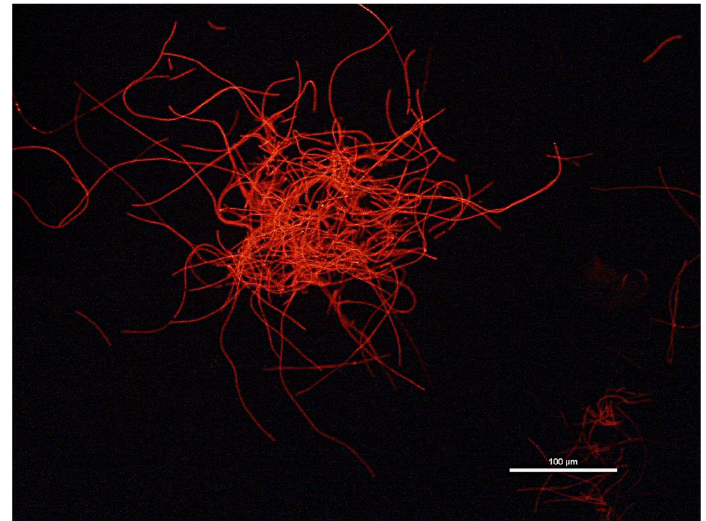
Figure 2. UV microphotograph of the cyanobiont culture obtained during passage (Nikon Eclipse 80i microscope, magnification 4x, UV2A filter, Nikon Instruments Europe B.V., Amsterdam, the Netherlands). Photo: A. Banach.